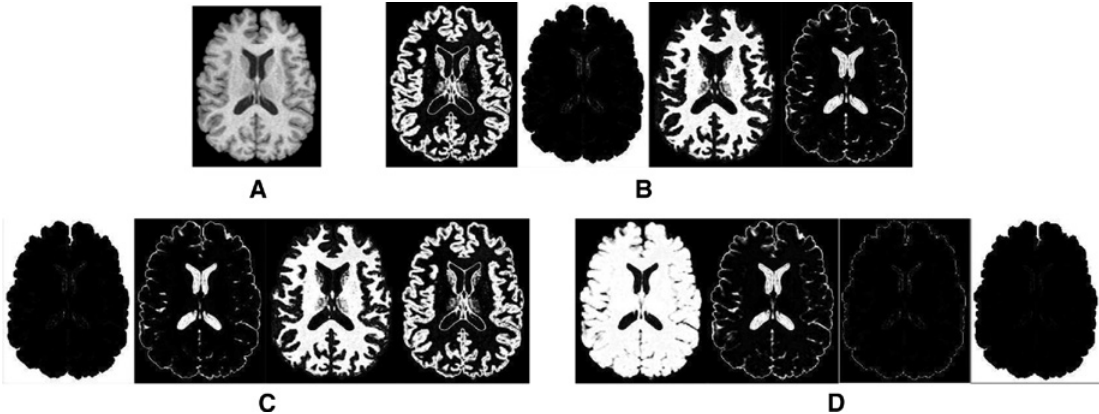
Figure 2: Segmentation Result of Alg2 With Different λ Values on Brain Image With Cluster Number = 4 (A) Input Image (B) λ = 0.5, (C) λ = 1, (D) λ = 5.